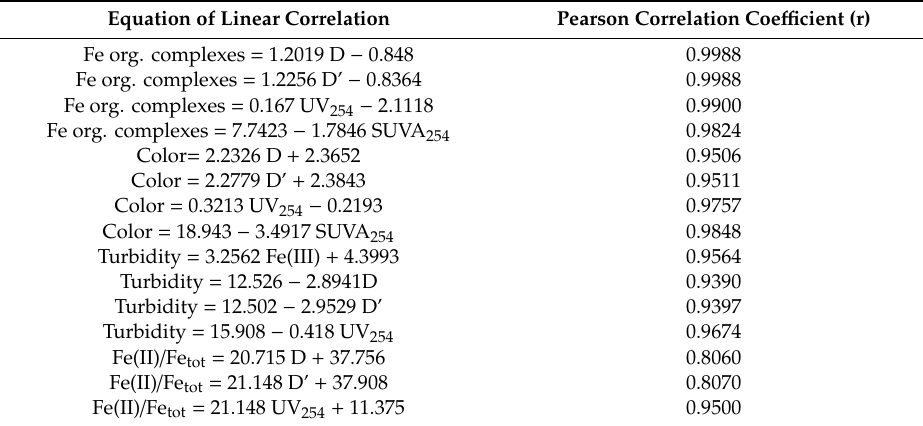
Table 2. Correlations between the indicators of the quality of groundwater